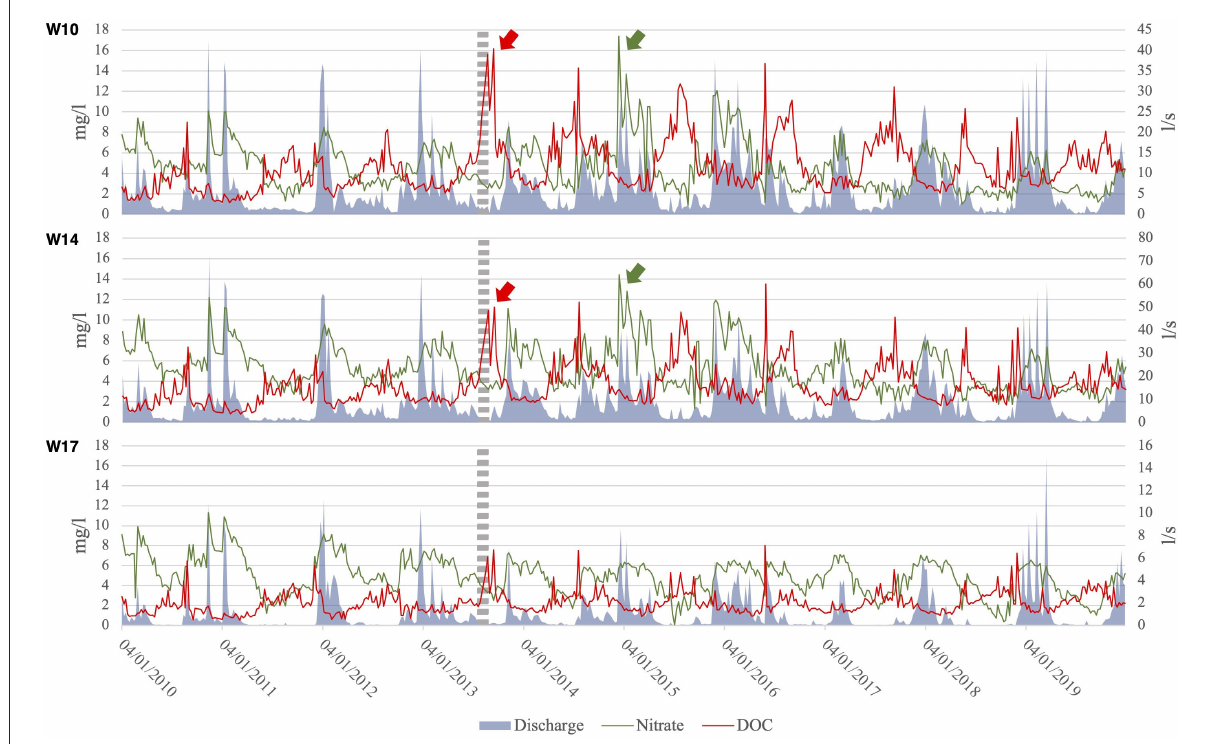
FIGURE4 Descriptive time series indicating nitrate and DOC concentrations and the daily average discharge measured at the water sampling locations. The grey dashed line is indicative of the time in which the deforestation took place and the red and green arrows indicate concentration spikes following the clear cut. W10 and W14 are within the deforested catchment and W17 is in the marginally disturbed reference catchment.